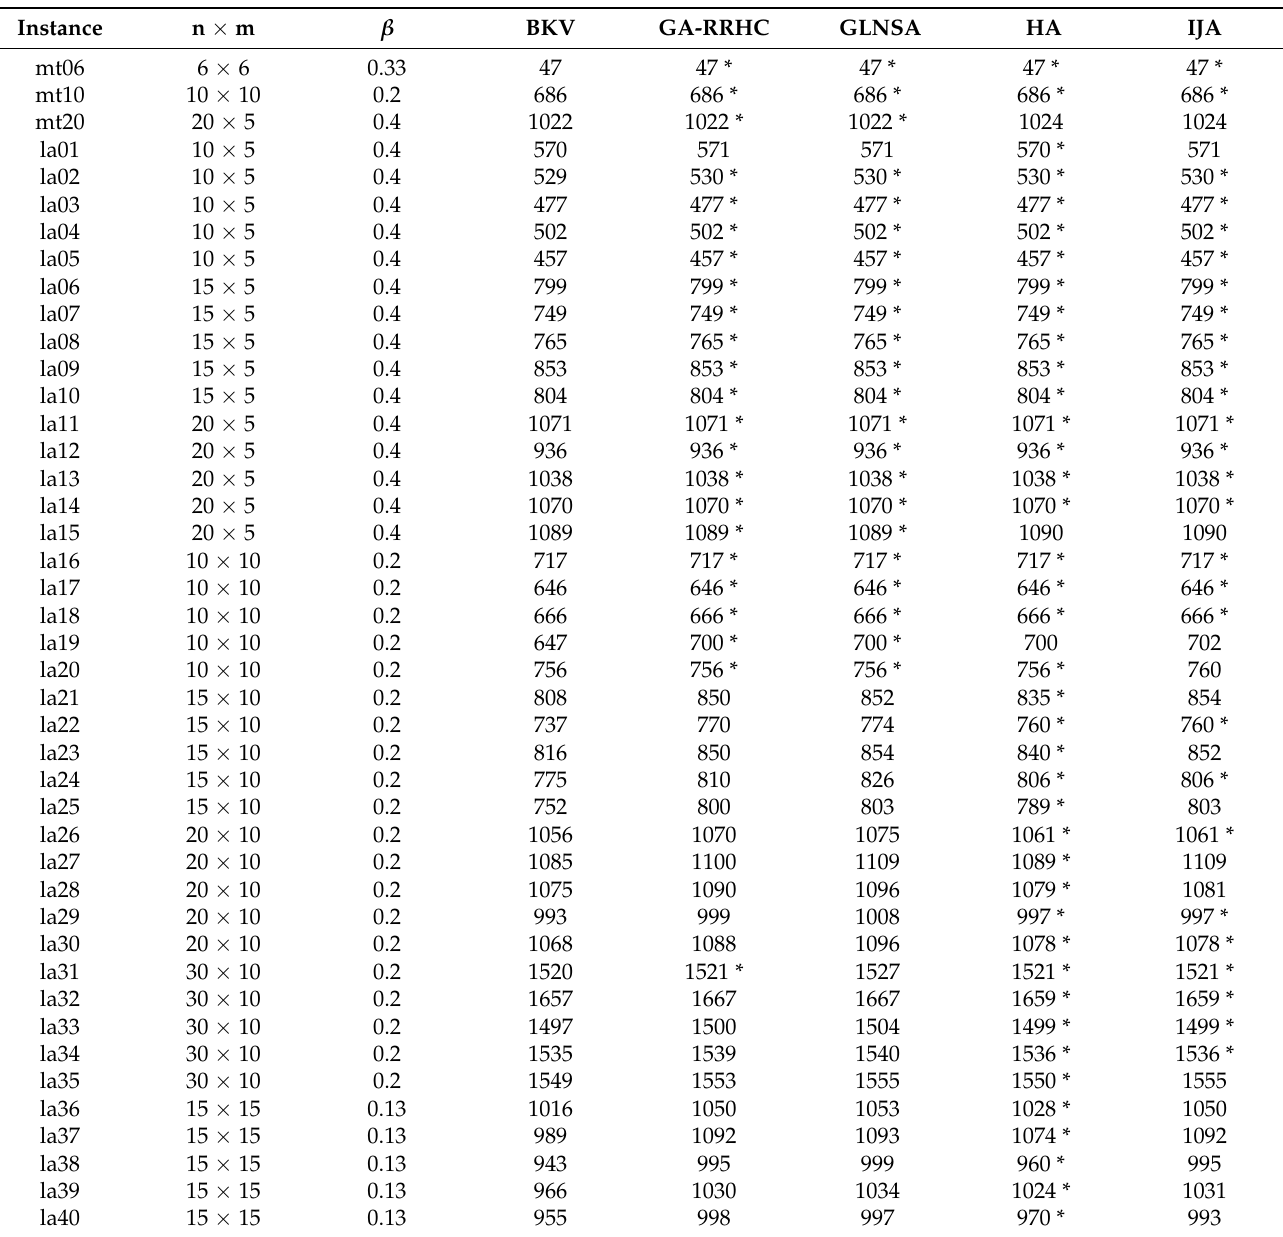
Table 7. Rdata dataset results, best makespan values are marked with *.